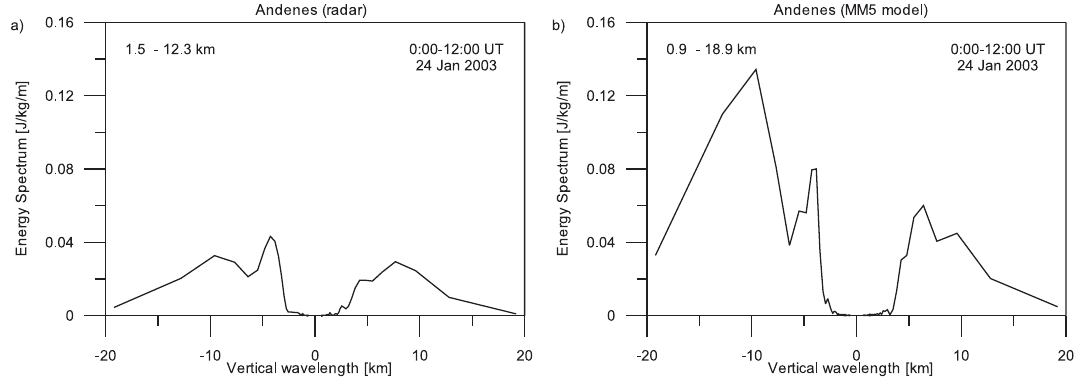
Fig. 5. Results of rotary spectra derived from vertical profiles of horizontal winds at Andenes from ALWIN radar data in the height range 1.5–12.3km (left) and MM5 model data in the height range 0.9–18.9km (right). The spectra are averaged for 12h starting from 00:00